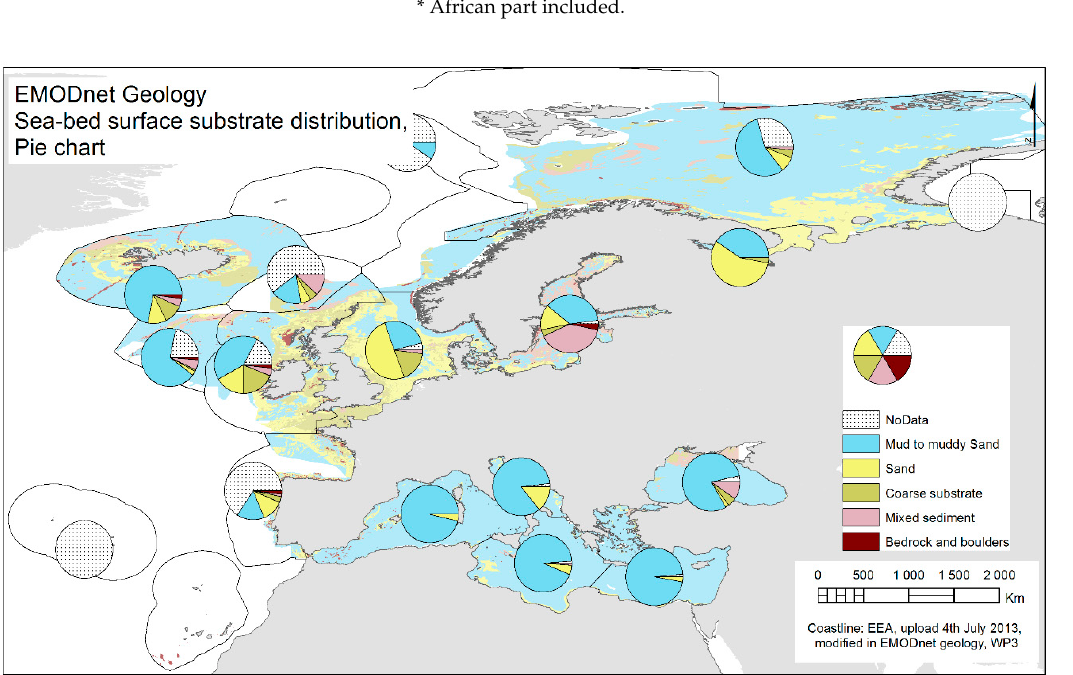
Figure 8. Distribution of seabed substrate types for different sea regions. “No data” gives the percentage of data gaps for a region.